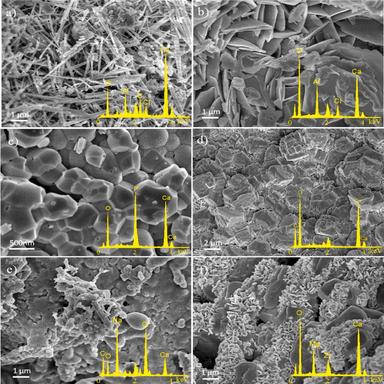
Surface morphology of IBA particle from NF-O.